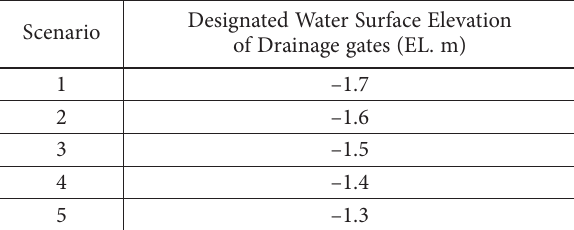
Table 6. Scenarios for the numerical simulation